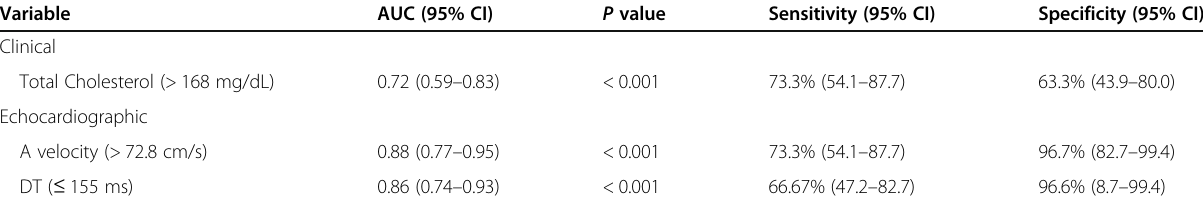
Table 6 ROC analysis for clinical and echocardiographic predictors of coronary tortuosity